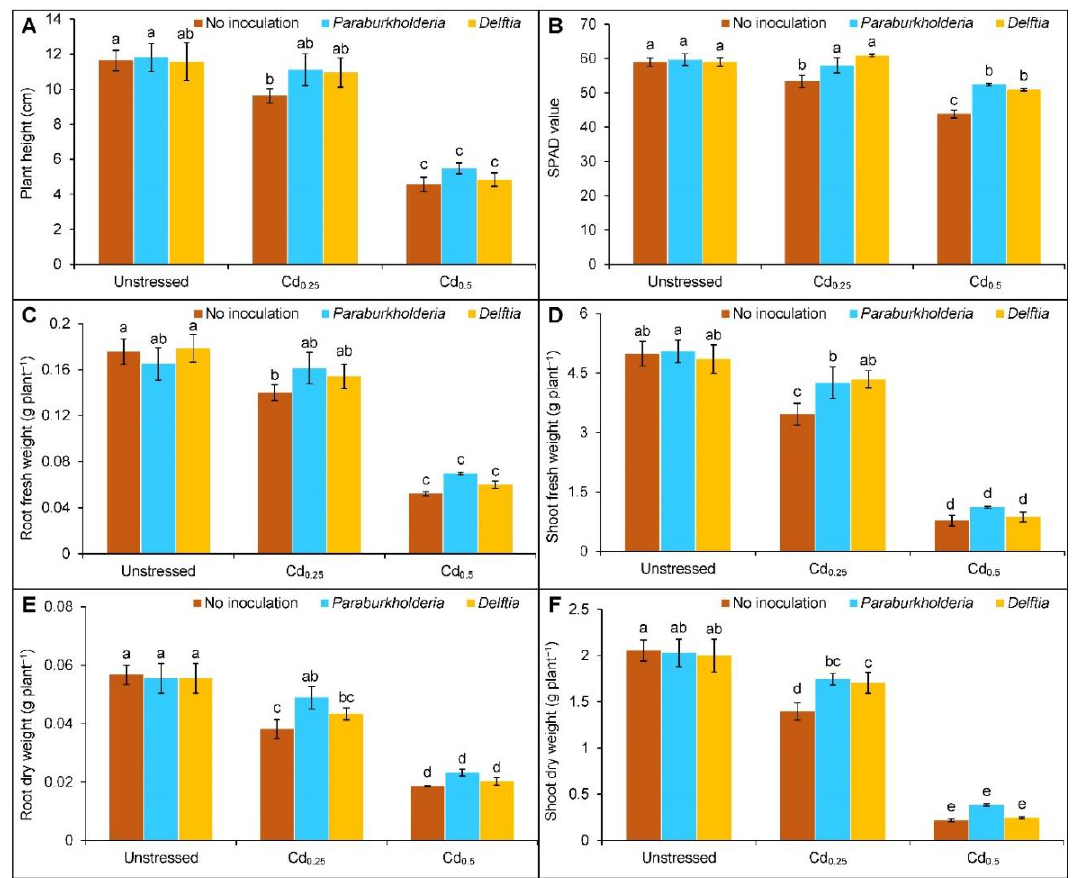
Figure 1. Effect of Paraburkholderia fungorum and Delftia sp. on the ( A ) plant height, ( B ) SPAD value, ( C ) root fresh weight, ( D ) shoot fresh weight, ( E ) root dry weight, and ( F ) shoot dry weight of rapeseed under different levels of CdCl 2 . Here, Cd 0.25 and Cd 0.5 indicated 0.25 and 0.5 mM CdCl 2 , respectively. Different letters on the bars indicate statistical significance at 5% levels of probability following Tukey’s HSD test and the mean (±SD) values obtained from three replications.